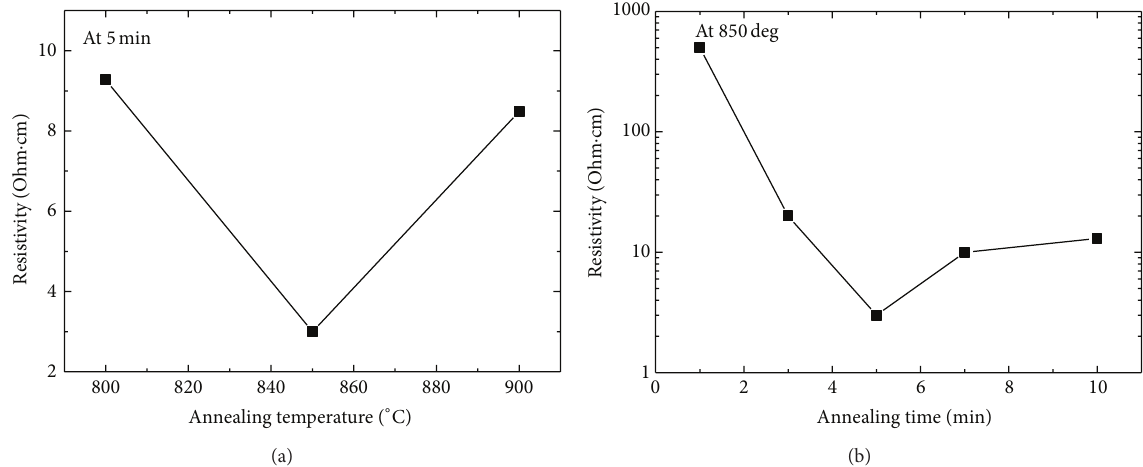
Figure 1: (a) The annealing temperature and (b) annealing time dependence of the conductivity of Mg-doped AlGaN p-type sample annealed by